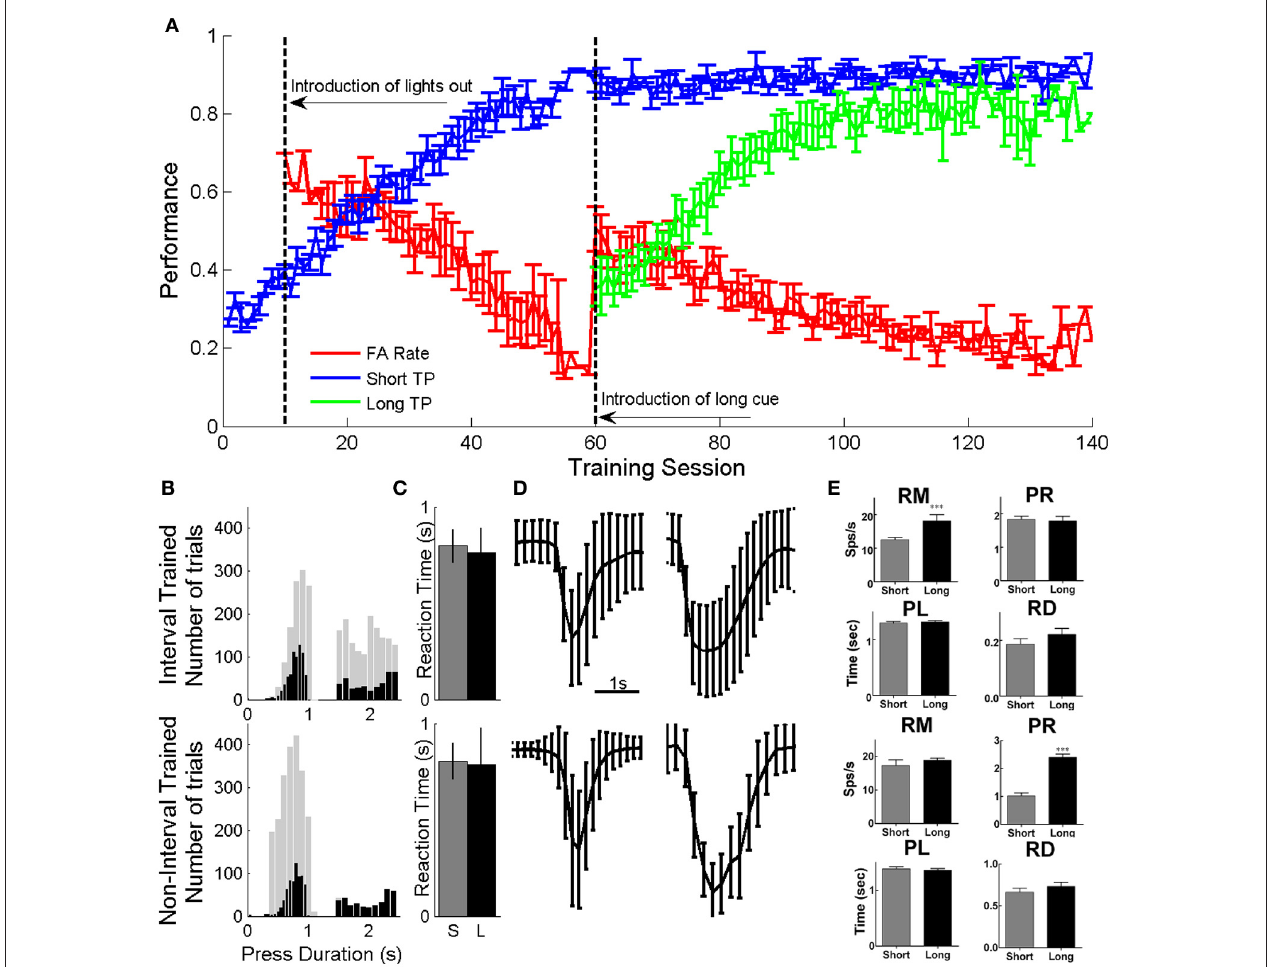
FIGURE 3 | Behavior and neural responses during the task. (A) Behavioral performance during phases of training expressed as the number of correct presses out of the total number of cues given. Animals gradually learned to associate short and long duration cues with short (blue) and long (green) duration presses, while, decreasing the rate at which spurious presses (False alarms—red) are made within 2s of cue presentation. A subset of these data were previously presented in Knudsen et al. (2011). (B) Original (gray) and reduced (black) press duration distributions for IT (top) and nIT (bottom) groups. Trials were removed from each group to allow similar distributions of short and long presses for comparison between groups. (C) There were no differences in average